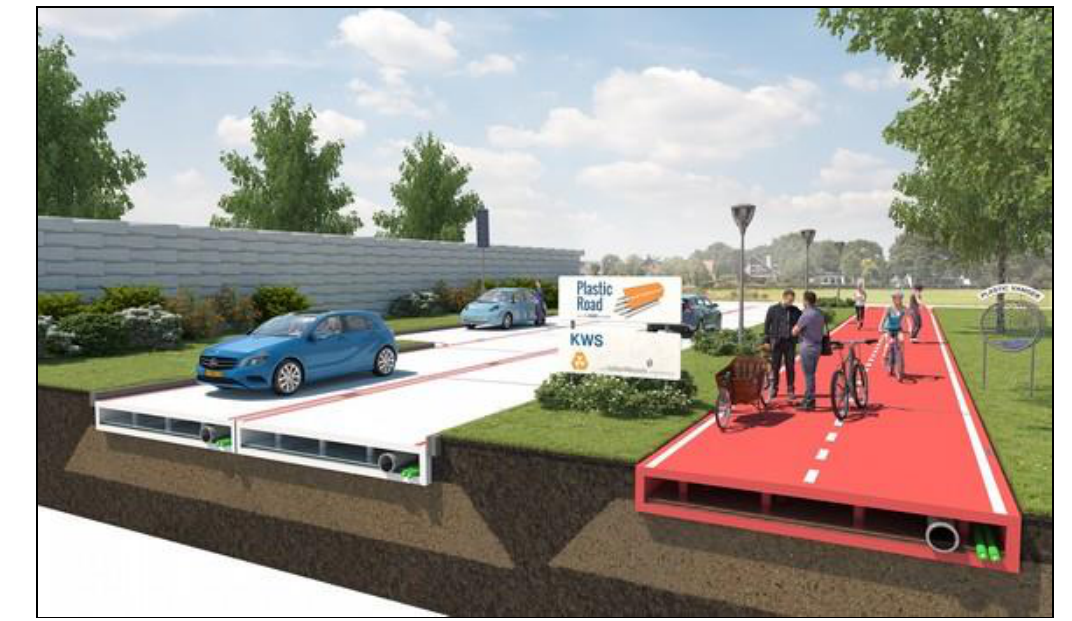
Figure 1. VolkerWessels plastic